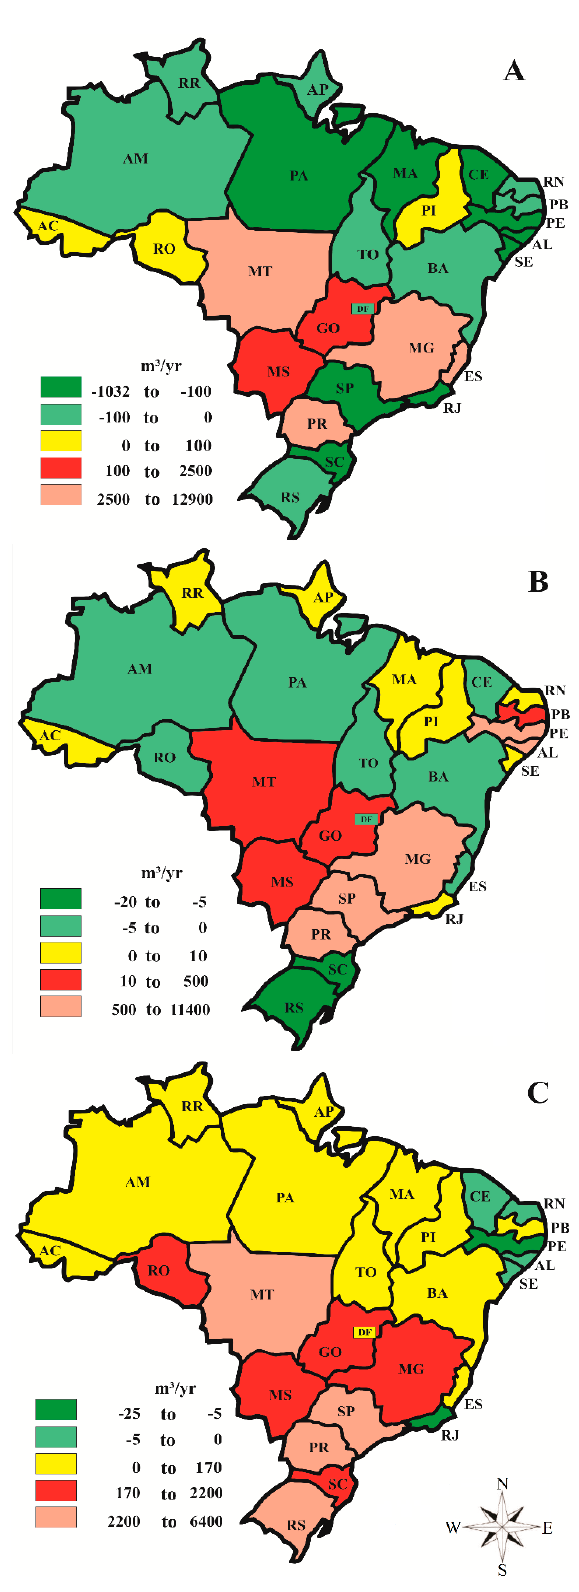
Figure 4. Net international virtual water export per state in Brazil during the period 1997–2012 by commodities type: crops ( A ); processed agricultural products ( B ); and livestock products ( C ). Negative values refer to net import.